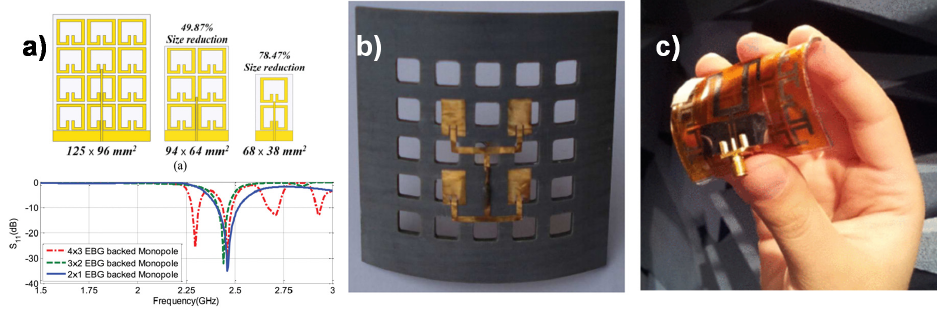
Figure 12. Miniaturized antennas. ( a ) Miniaturization of EBG-backed monopole antenna with reflection coefficient [212], ( b ) fabricated cylindrical conformal array antenna with photonic bandgap (PBG) lattice [221], and ( c ) Prototype of an M-shaped printed monopole antenna and slotted Jerusalem Cross (JC)-artificial magnetic conductor (AMC) [208].